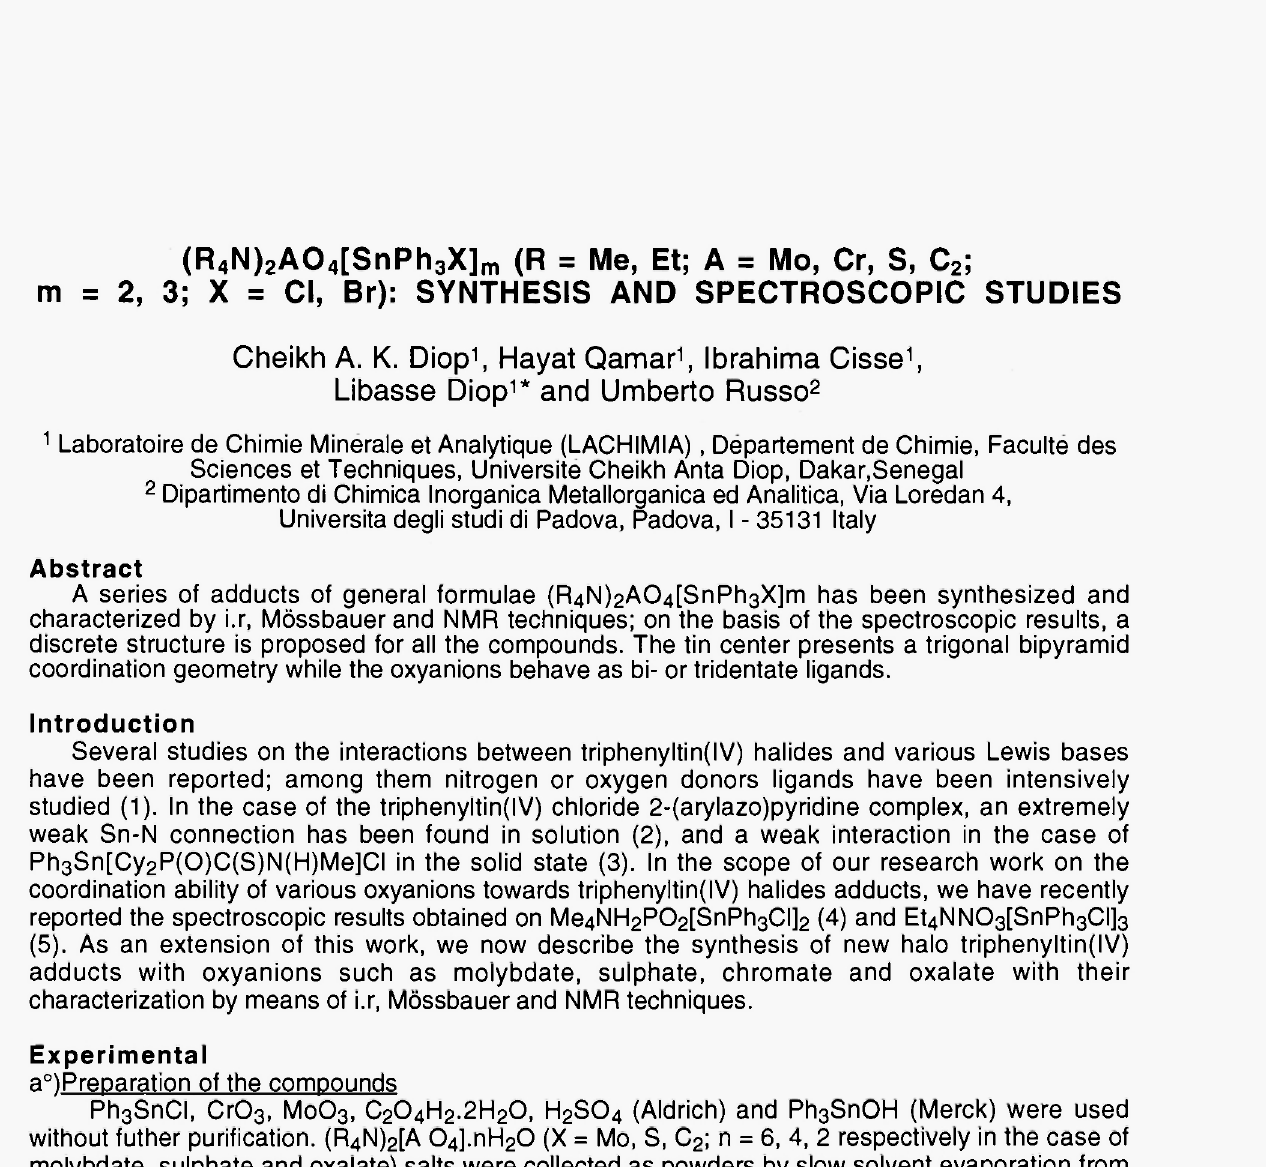
Table 1: Elemental analyses of the title adducts. Compounds